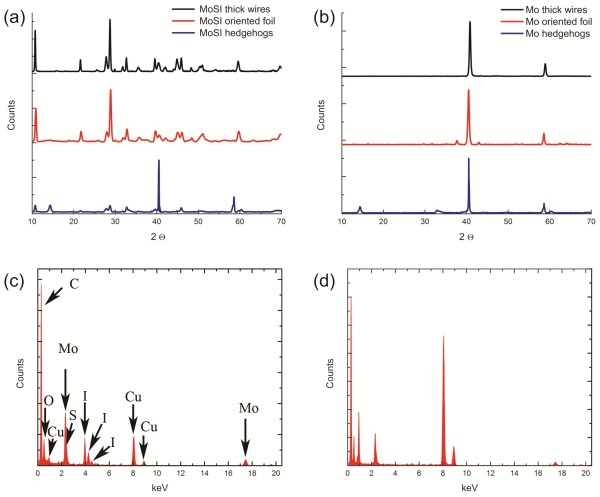
X-ray diffraction pattern and EDS spectrum for MoSI NWs and hydrogenated samples. (a) X-ray diffraction pattern for MoSI of different morphology. (b) X-ray diffraction pattern for hydrogenated samples in (a). (c) Typical example of EDS spectrum for MoSI NW. (d) EDS spectrum after hydrogenation shows clearly the absence of I and S peaks indicating transformation to Mo NW.